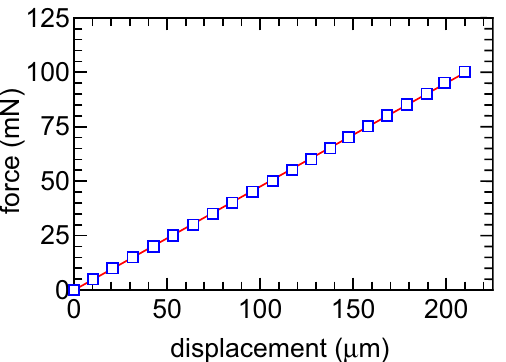
Figure 10. Calibration curve relating the displacement to the force, where the displacement is measured by the laser displacement sensor when applying known axial forces to the